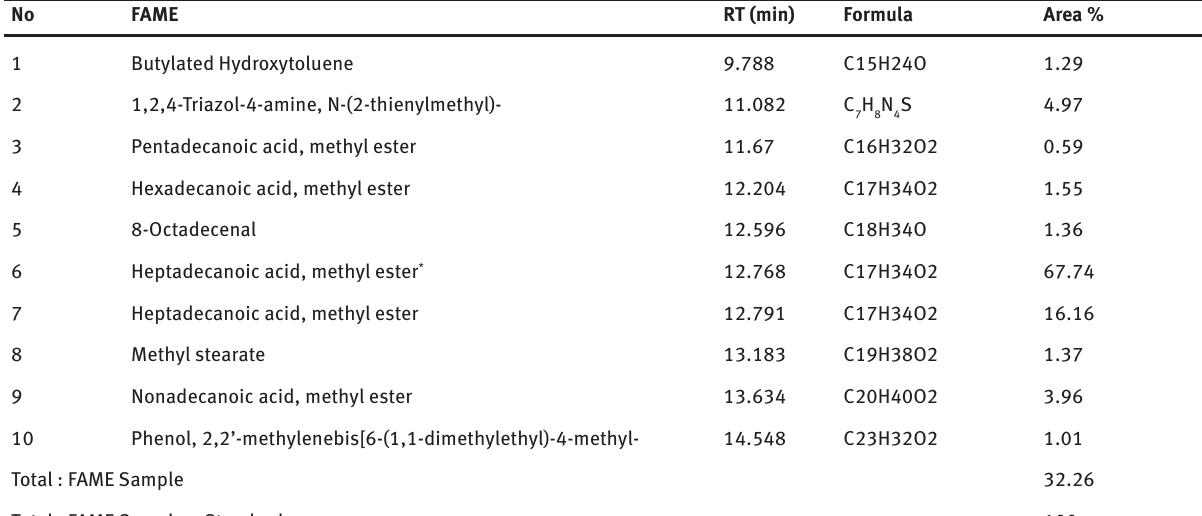
Table 1: FAME composition of Chlorella vulgaris .